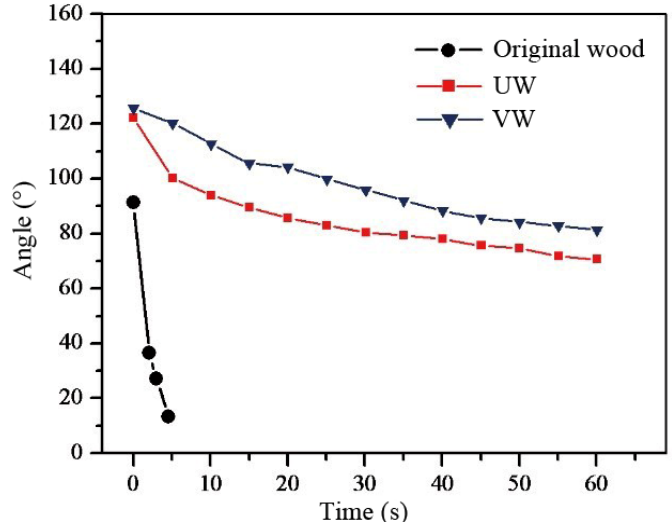
Figure 9. Dynamic water contact angle of specimens.